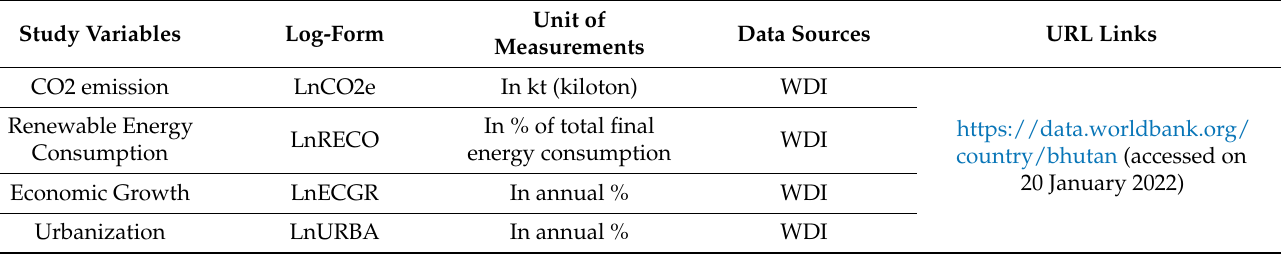
Table 2. Description of variables for the